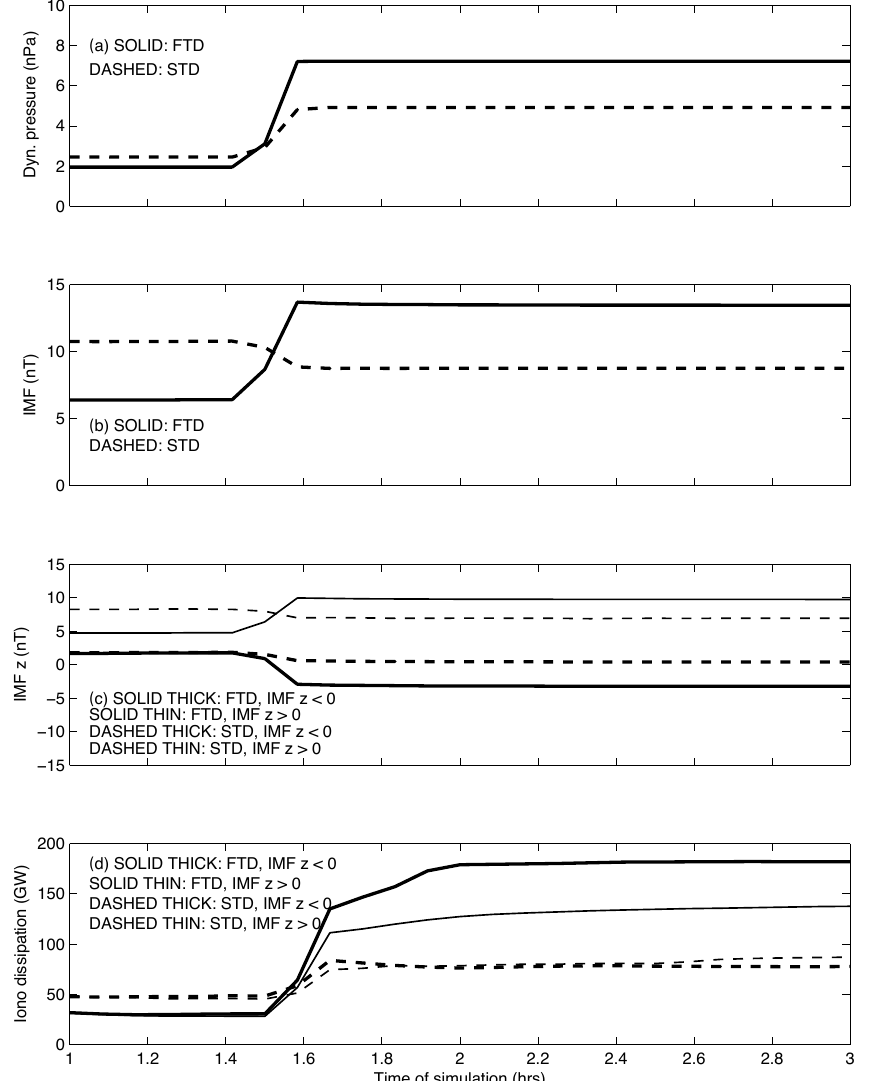
Fig. 9. Four simulation runs investigating the ionospheric response to FTD and STD events: (a) The solar wind dynamic pressure, (b) IMF, (c) IMF z component, and (d) global ionospheric energy deposition. Solid thick (thin) lines indicate the FTD runs with IMF southward (northward) turning at the time of the impulse. Dashed thick (thin) lines indicate the STD runs with IMF southward (northward) turning at the time of the impulse. The dynamic pressure and the IMF magnitude are the same for the FTD and STD runs and hence the thin solid and dashed lines are not visible in panels (a) and